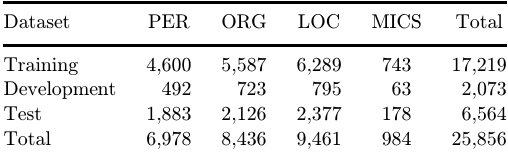
Table 2. The statistics of VLSP 2018 NER